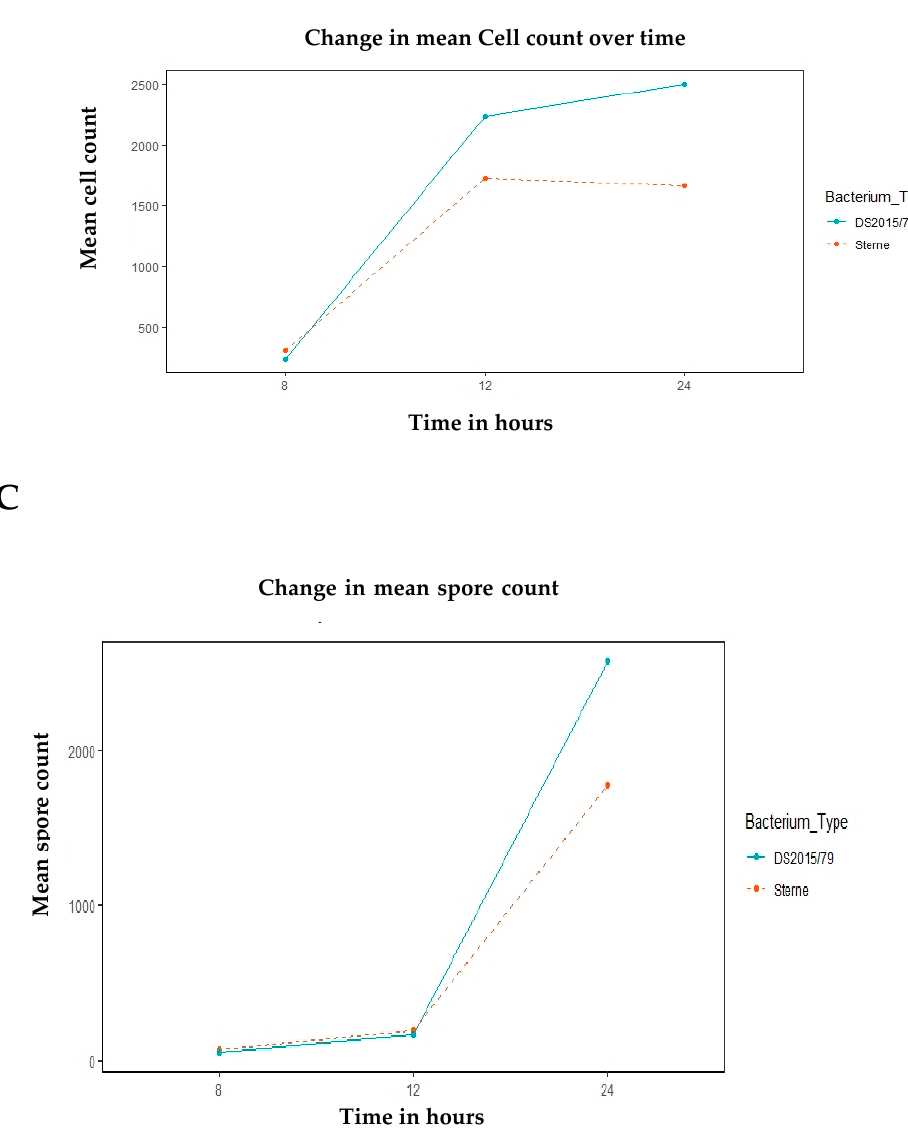
Figure A2. ( A ): Median of endpoint cell counts between Bacillus anthracis strains DS201579 and Sterne vaccine strain. ( B ): Mean cell counts between Bacillus anthracis strains DS201579 and Sterne vaccine strain. ( C ): Mean spore counts between Bacillus anthracis strains DS201579 and Sterne vaccine strain. Figure A3A,B: Absence of phage equates to more cells and spores of Bacillus anthracis control strain Sterne 34F2 (because there is no predation).